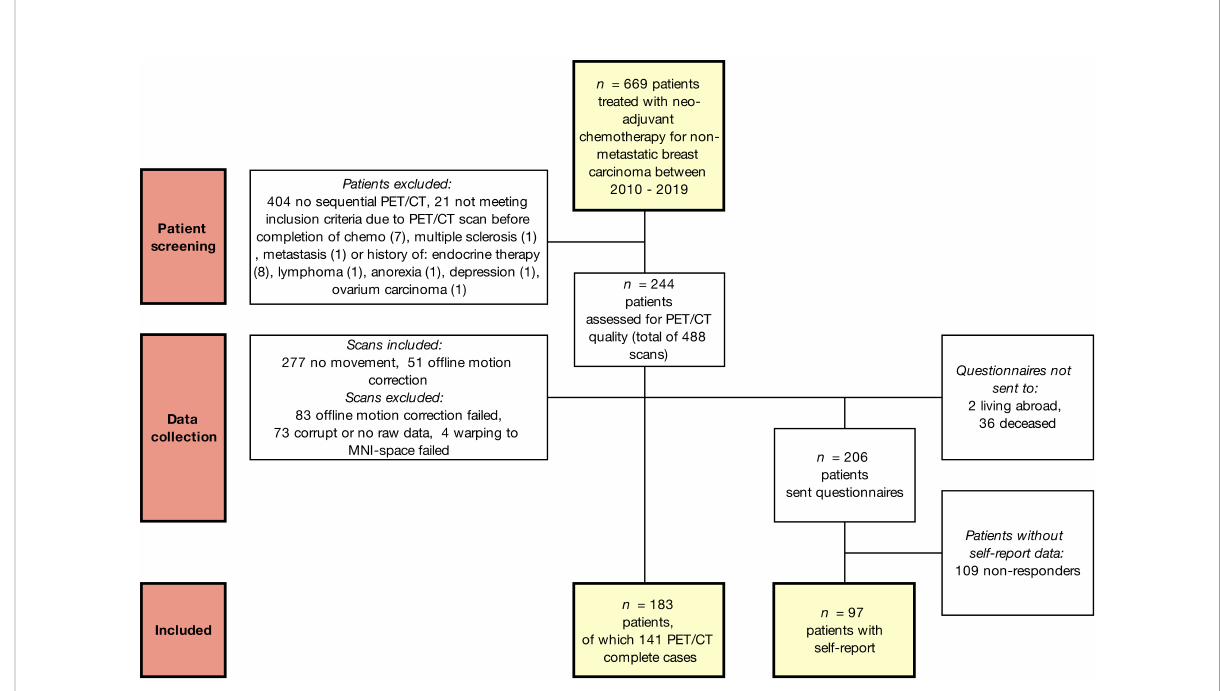
FIGURE 1 Flow chart of included patients and data. Robust mixed-effects modelling ensured incomplete cases could also be included in the statistical